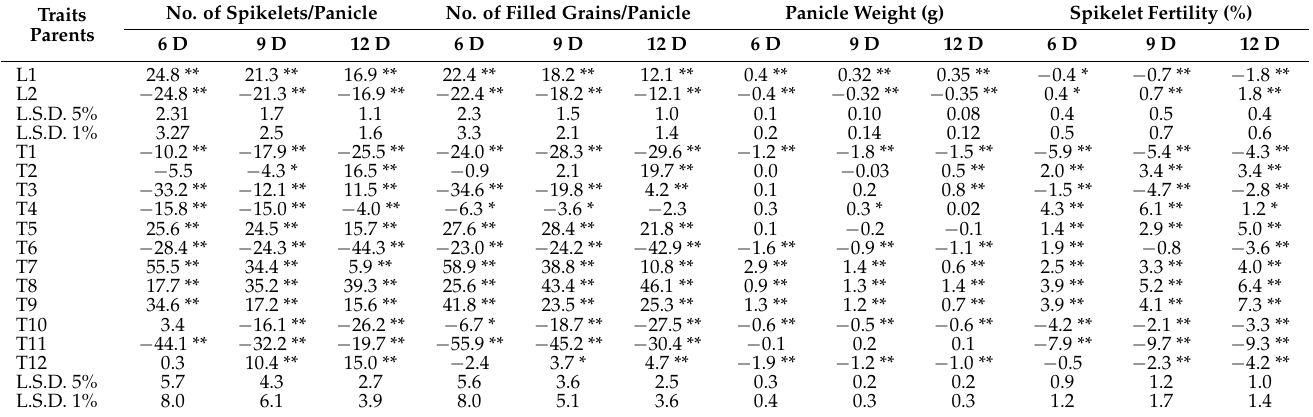
Table 6. General combining ability effects of the parental lines for no. of spikelets/panicle, no. of filled grains/panicle, panicle weight and spikelet fertility percentage